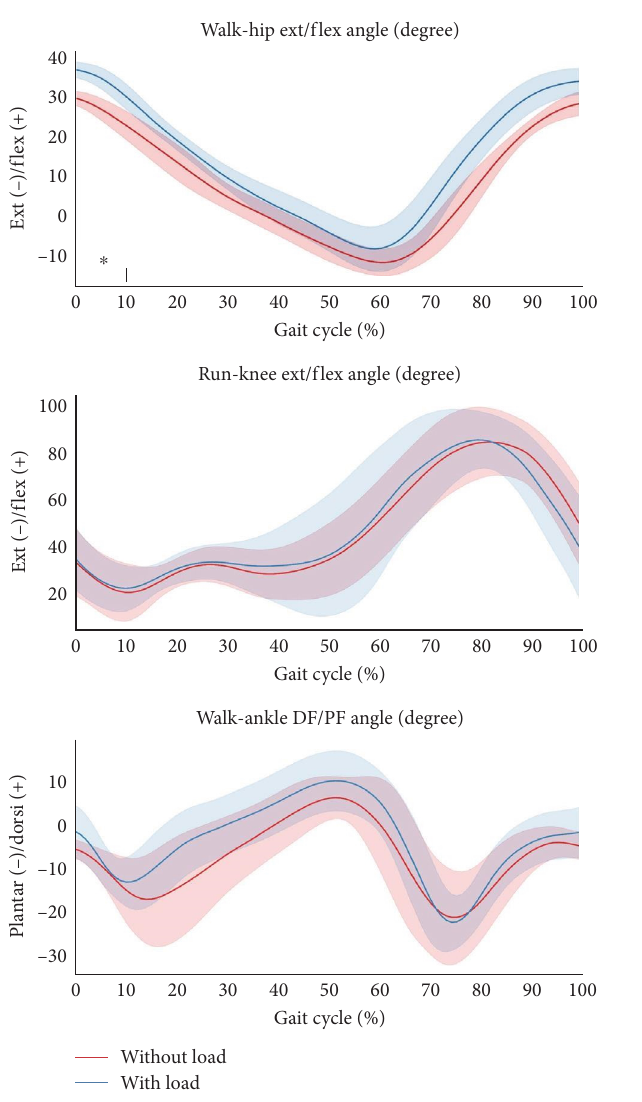
F IGURE 3: Raw data of the hip, knee, ankle joint angles during walk- ing with and without load carriage. The x -axis shows the normal- ized gait cycle in percentage. ∗ Indicates a signi fi cant difference between with and without load carriage ( p < : 05).